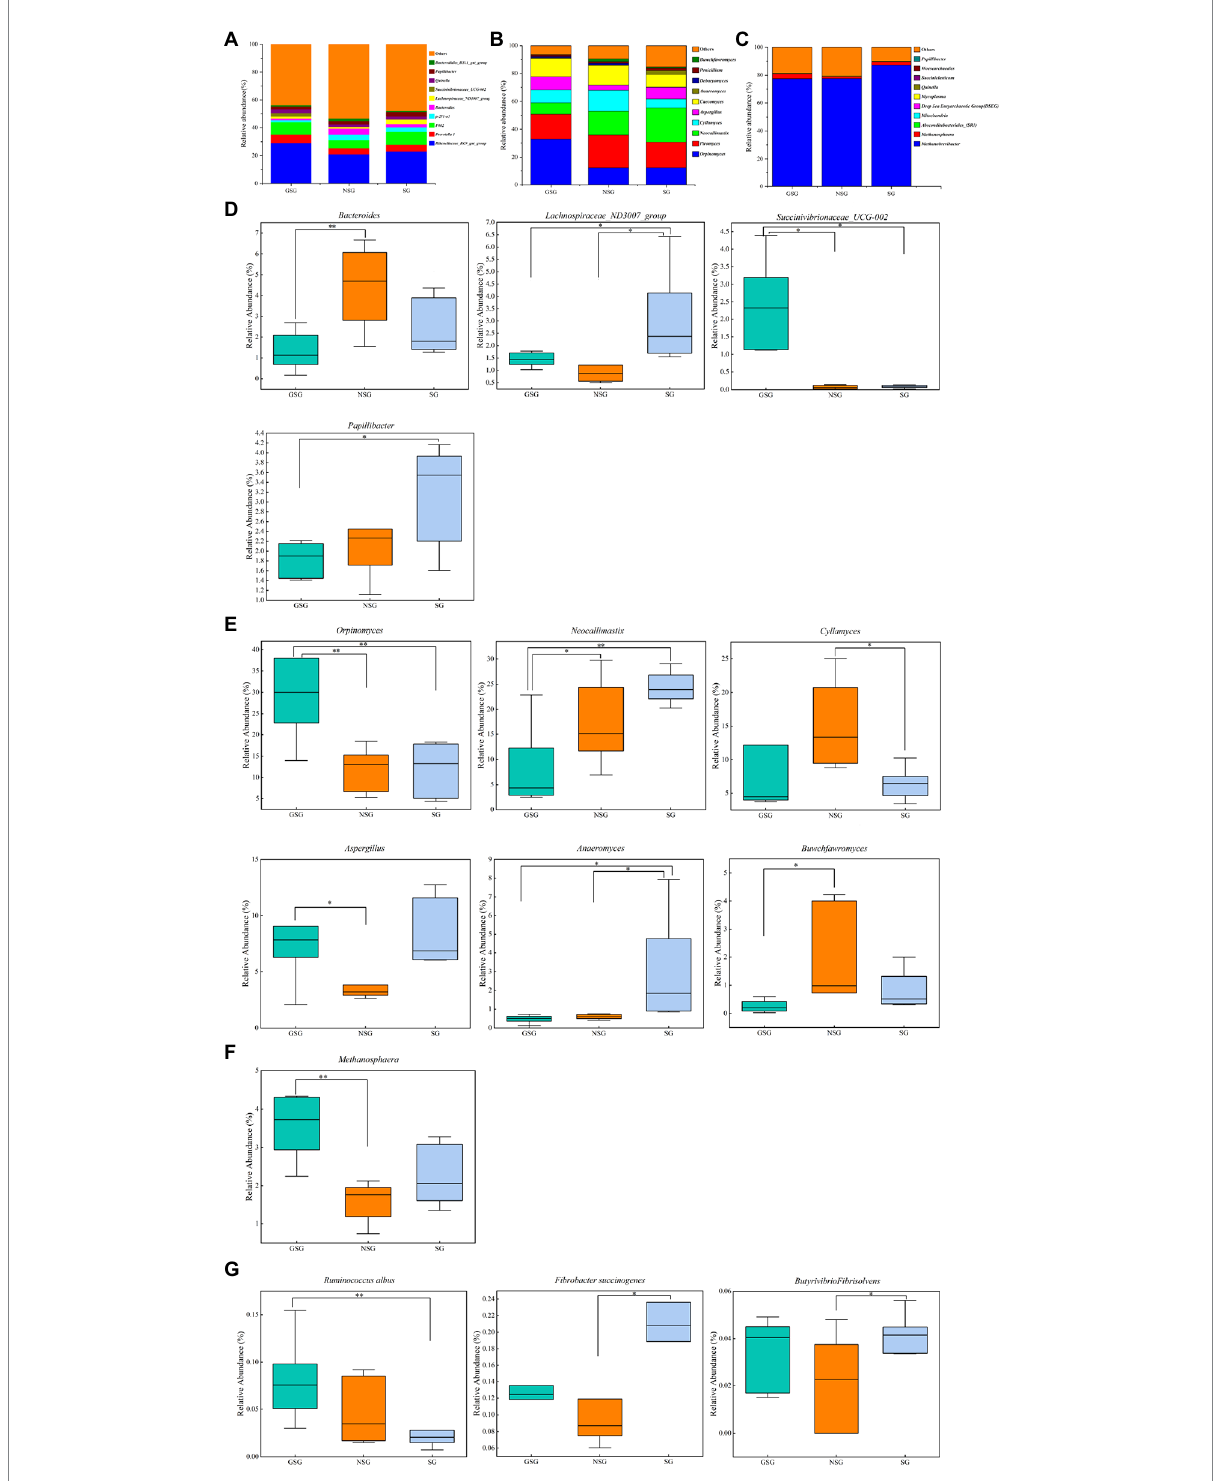
FIGURE 4 Classification of the rumen microbial composition at the genus level across the different nutrient simulations in different grazing patterns. (A) Bacteria. (B) Fungi. (C) Archaea. (D) Bacterial genera with significant changes under various nutrient simulations. (E) Fungal genera with significant changes under various nutrient simulations. (F) Archaeal genera with significant changes under various nutrient simulations. (G) Major fiber-degrading bacteria with significant changes under various nutrient simulations. Asterisks indicate significant difference between the three groups ( * p ≤ 0.05; ** p ≤